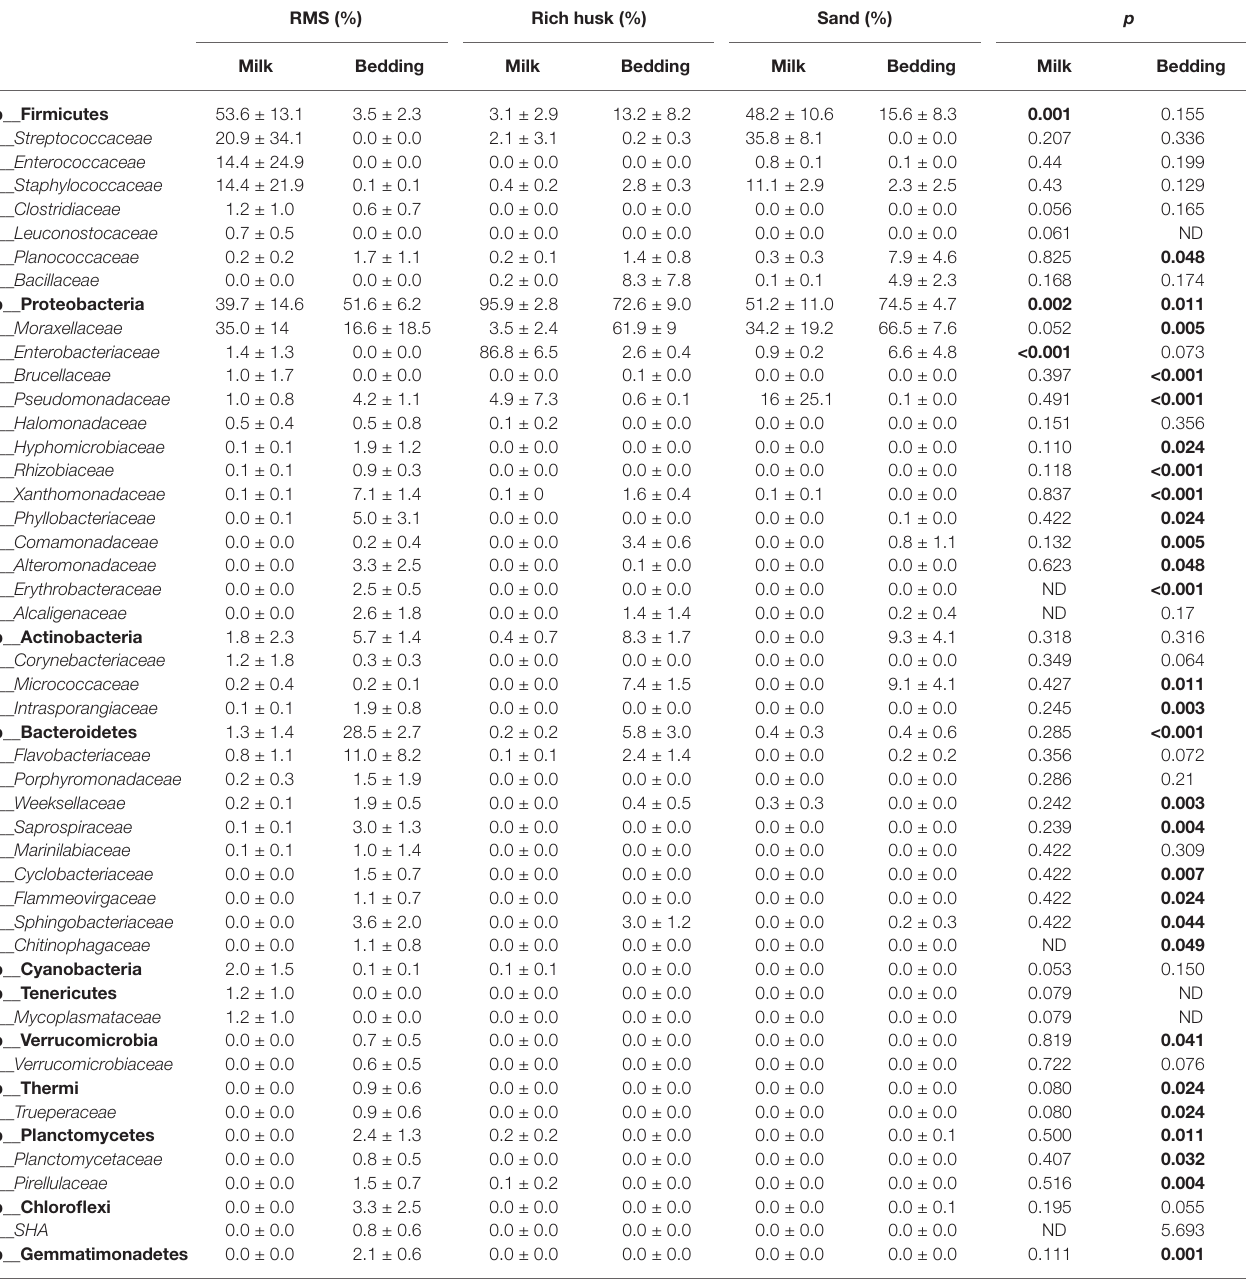
TABLE 3 | Relative read abundance of different bacterial community structures at the phylum and family levels in different groups. RMS (%) Rich husk (%) Sand (%) p Milk Bedding Milk Bedding Milk Bedding Milk Bedding